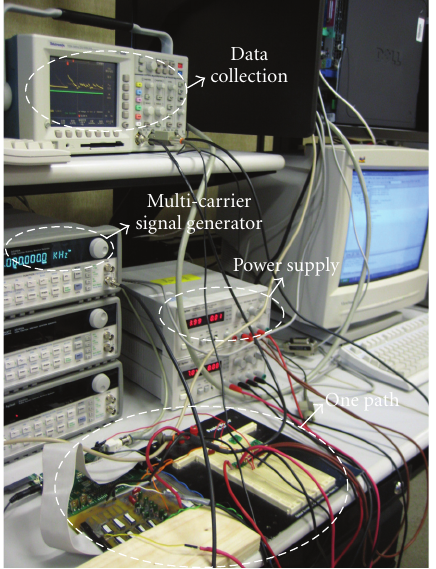
Figure 17: Testing setup of the prototype.